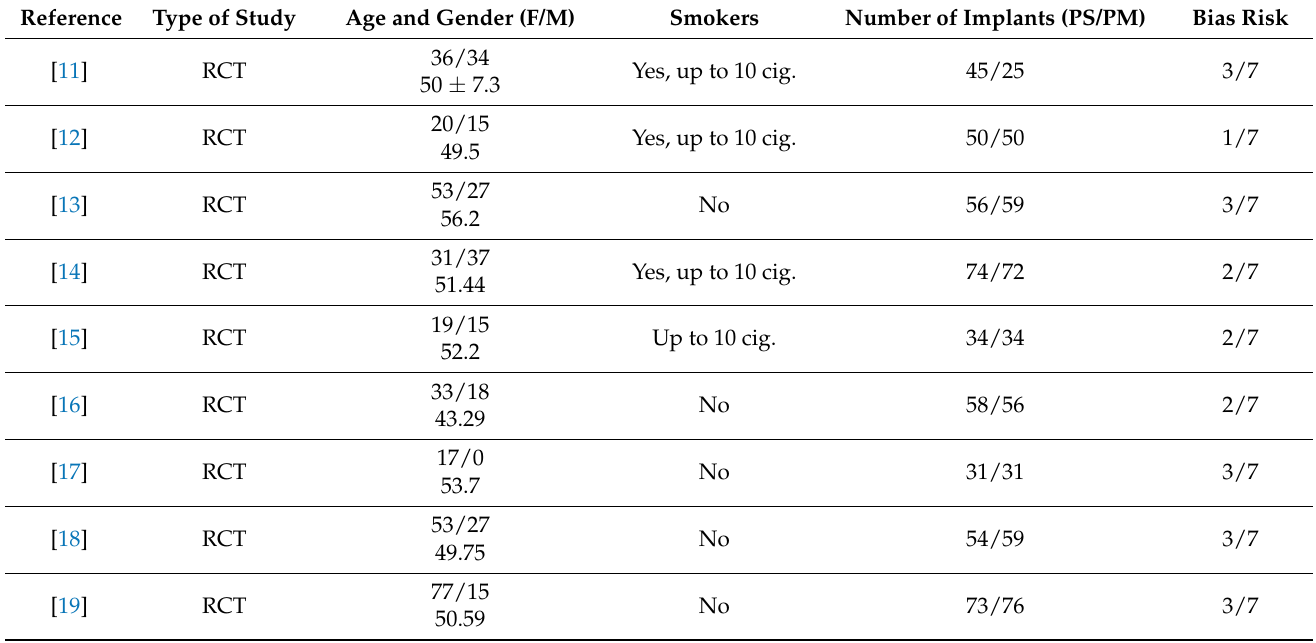
Table 1. Sample and quality of the